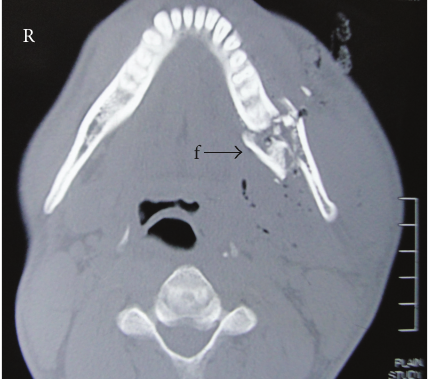
Figure 5: Axial CT scan showing multiple fractures of the mandible with inward